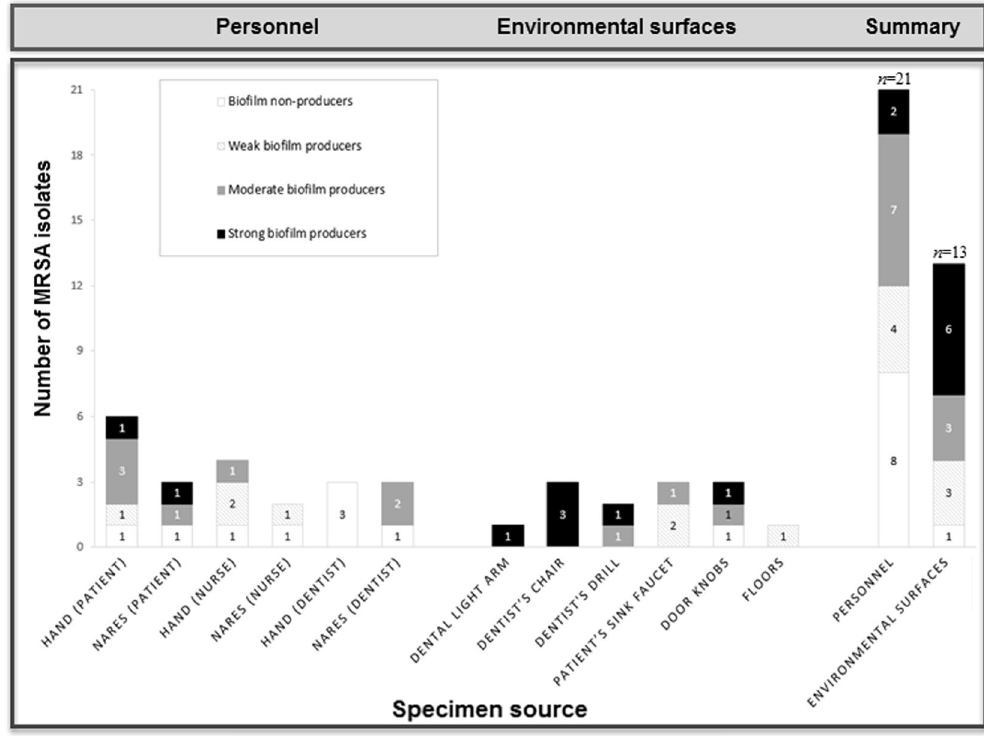
Figure 2. Biofilm-forming abilities of the tested MRSA isolates in relation to the specimen